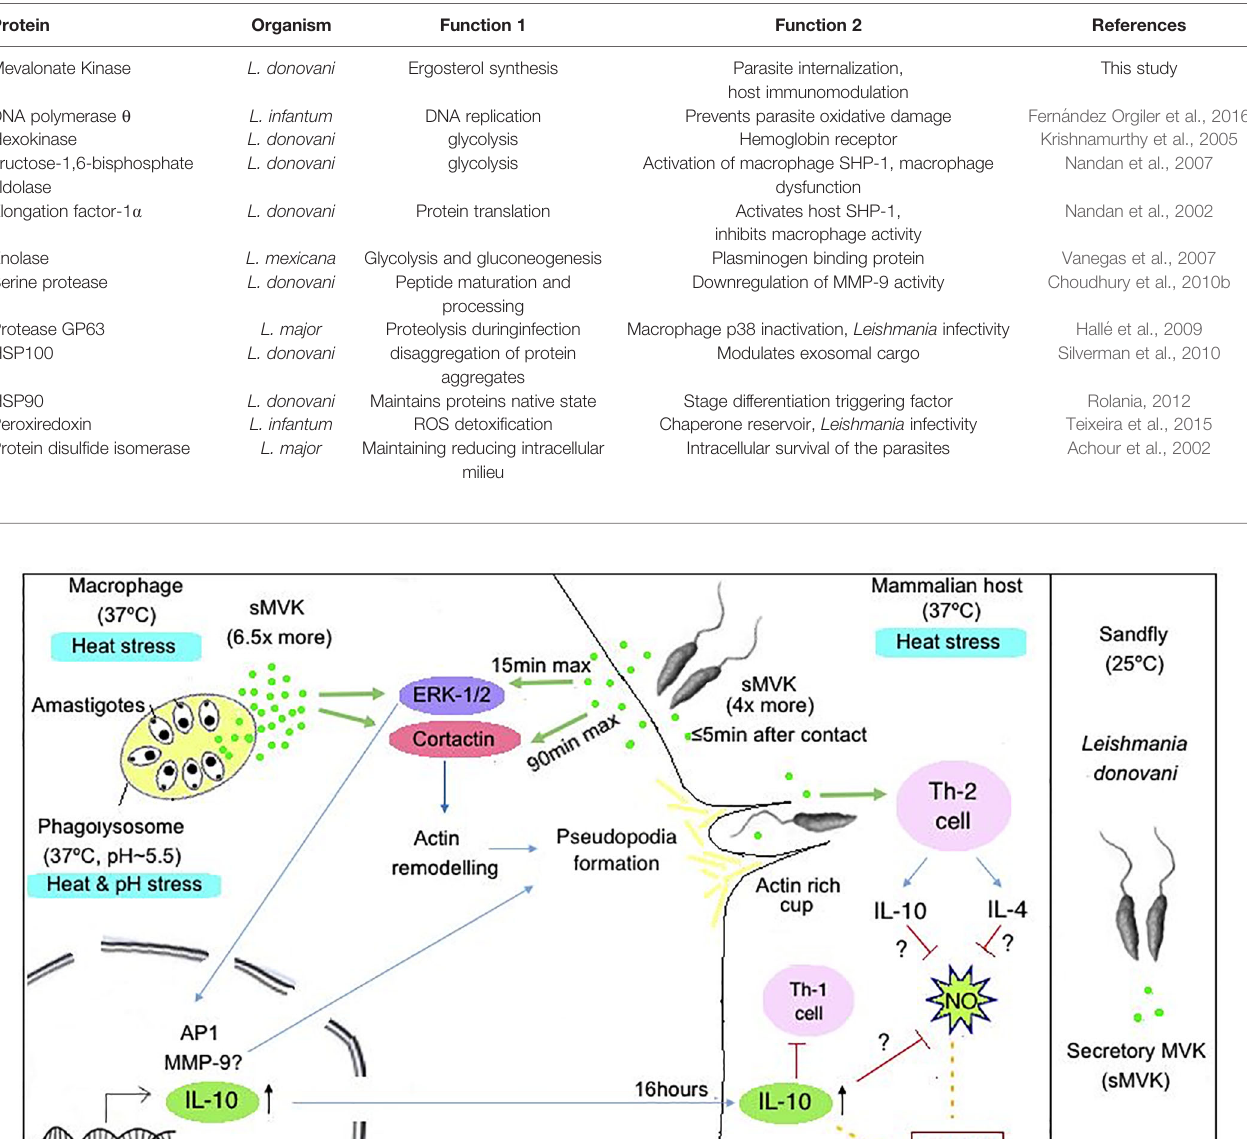
TABLE 2 | Some Leishmania proteins with dual function.